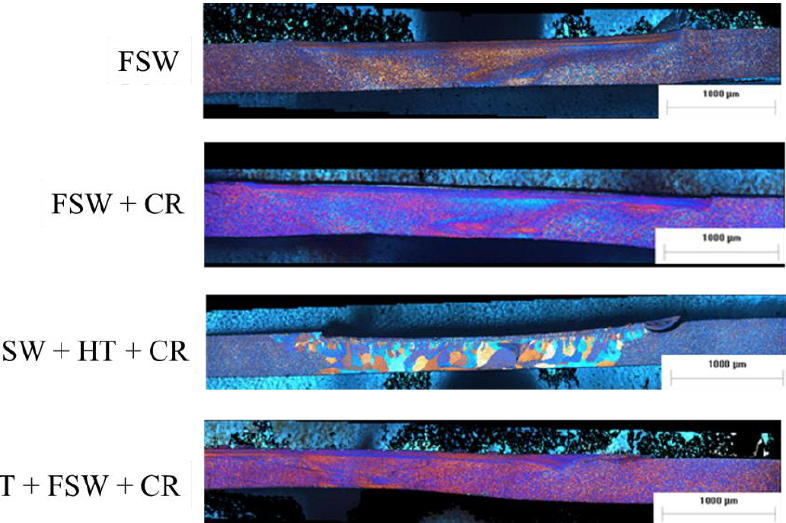
Figure 5. Comparison of panoramic POM micrographs of the welding joints processed with condi- tion B.